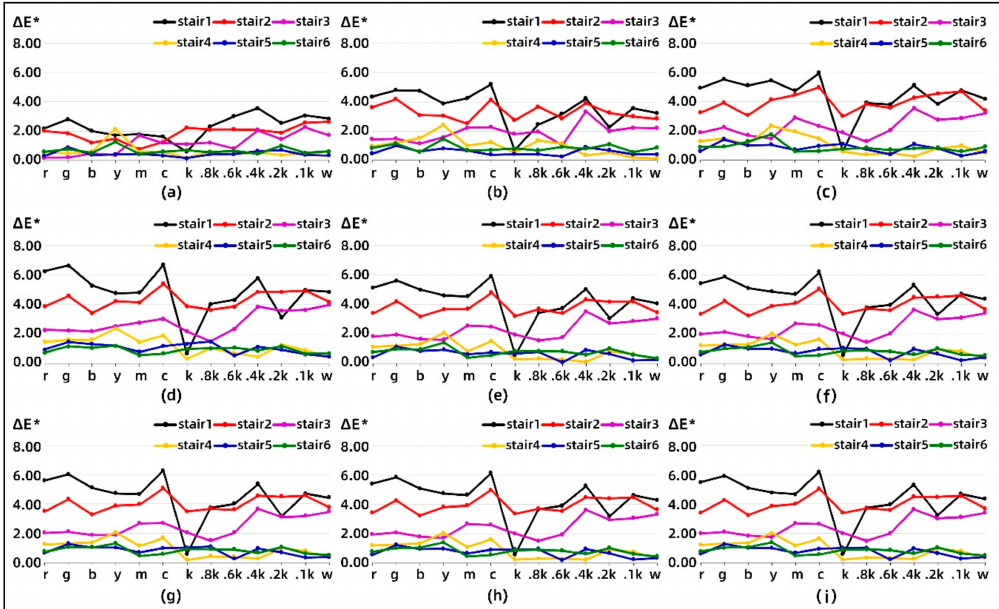
Figure 2. Comparison of the color difference between the multi-layer sample and Sample 1: ( a ) 2 layers, ( b ) 3 layers, ( c ) 4 layers, ( d ) 5 layers, ( e ) 6 layers, ( f ) 7 layers, ( g ) 8 layers, ( h ) 9 layers, and ( i ) 10